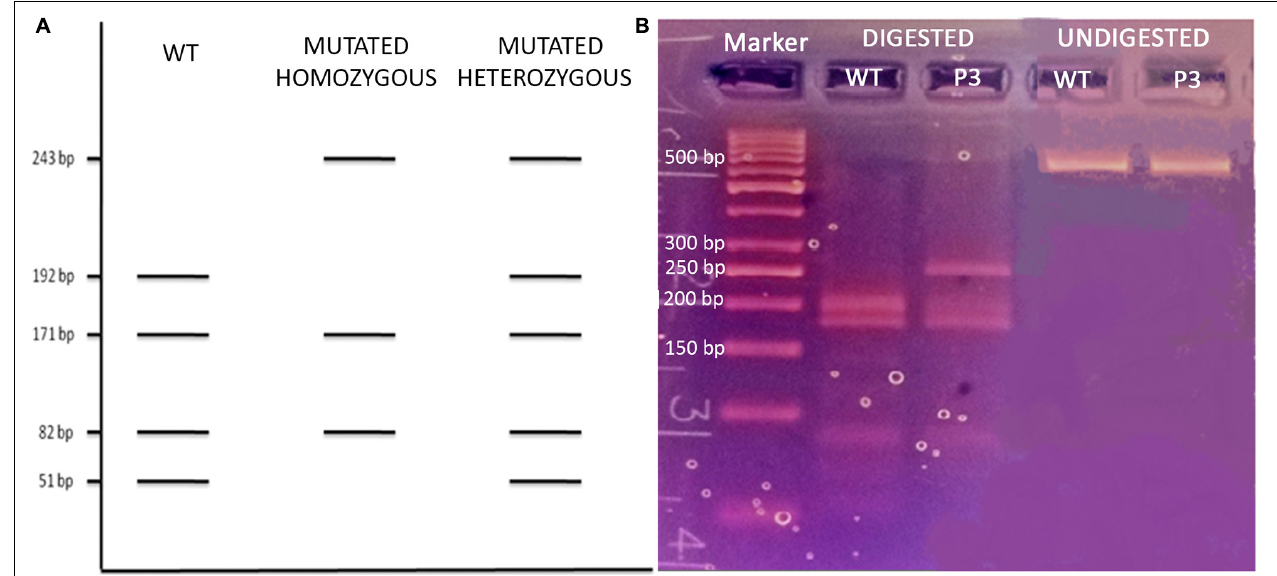
FIGURE 3 | (A) Schematic representation of the AluI enzyme digestion on a wild-type, homozygous, and heterozygous mutated TGFB1 fragment; (B) 3% agarose gel electrophoresis of the AluI enzyme digested and undigested P3 and WT